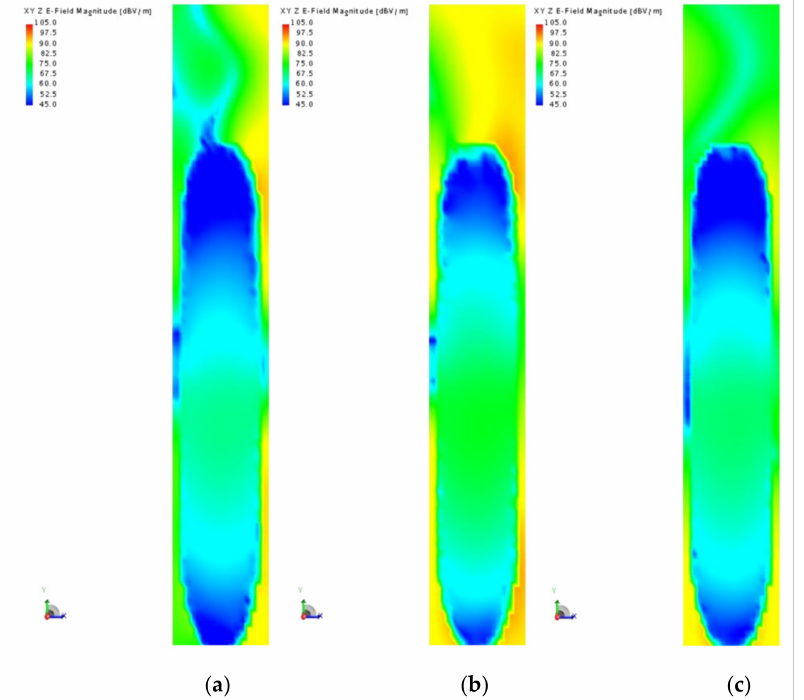
Figure 10. Electric field strength distribution E ( t ) of inner layer at different times t. ( a ) t = 0 ns,